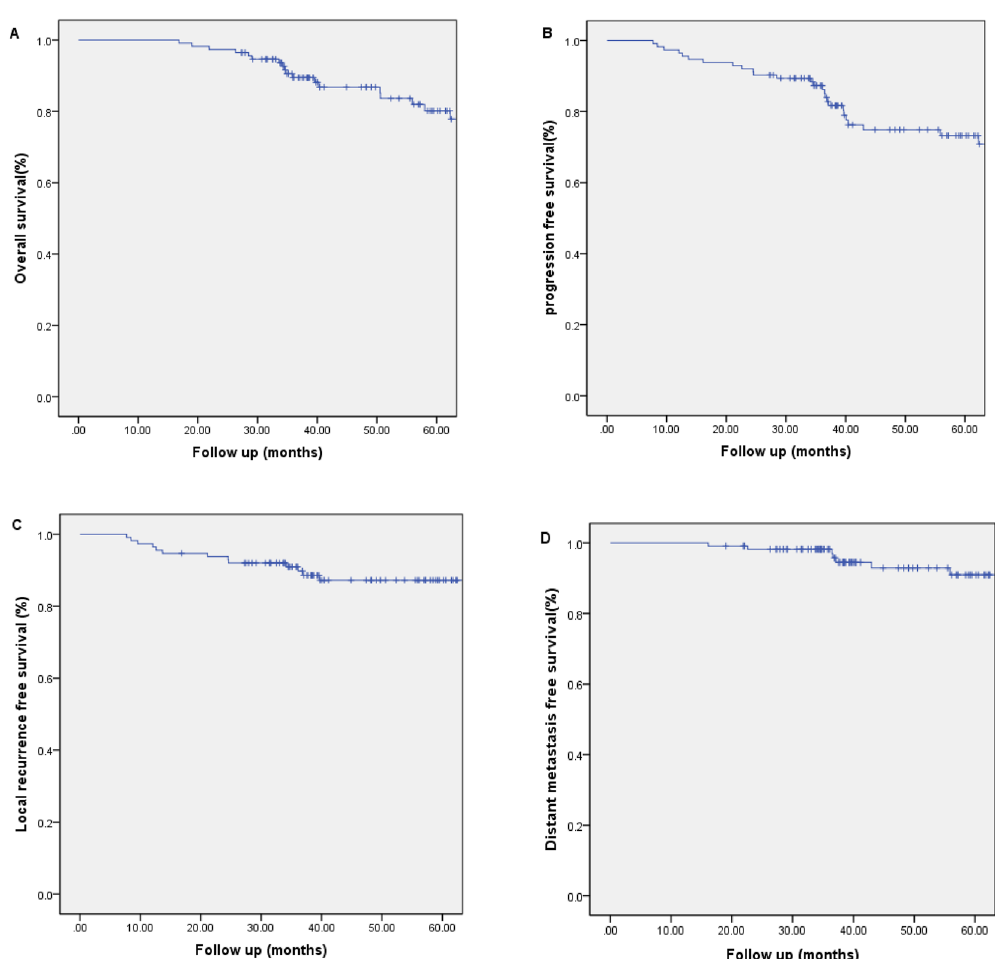
Figure 1. Overall survival, progression-free survival, local recurrence-free survival and distant metastasis-free survival rates of induction chemotherapy-concurrent chemoradiotherapy (IC-CCRT) in NPC